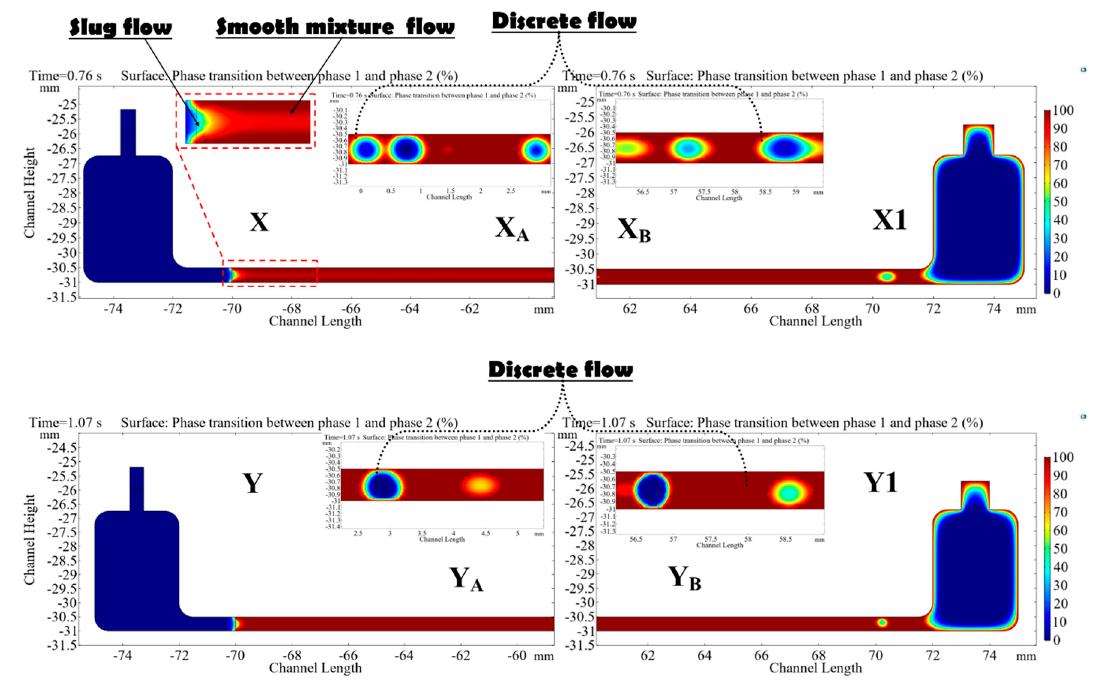
Figure 13. Flow boiling heat transfer with increasing temperature at the top and bottom walls: [X-Y] Channel inlet area, [X1-Y1] Channel outlet area, [X A -X B -Y A -Y B ] Random section of the middle along the horizontal channel.